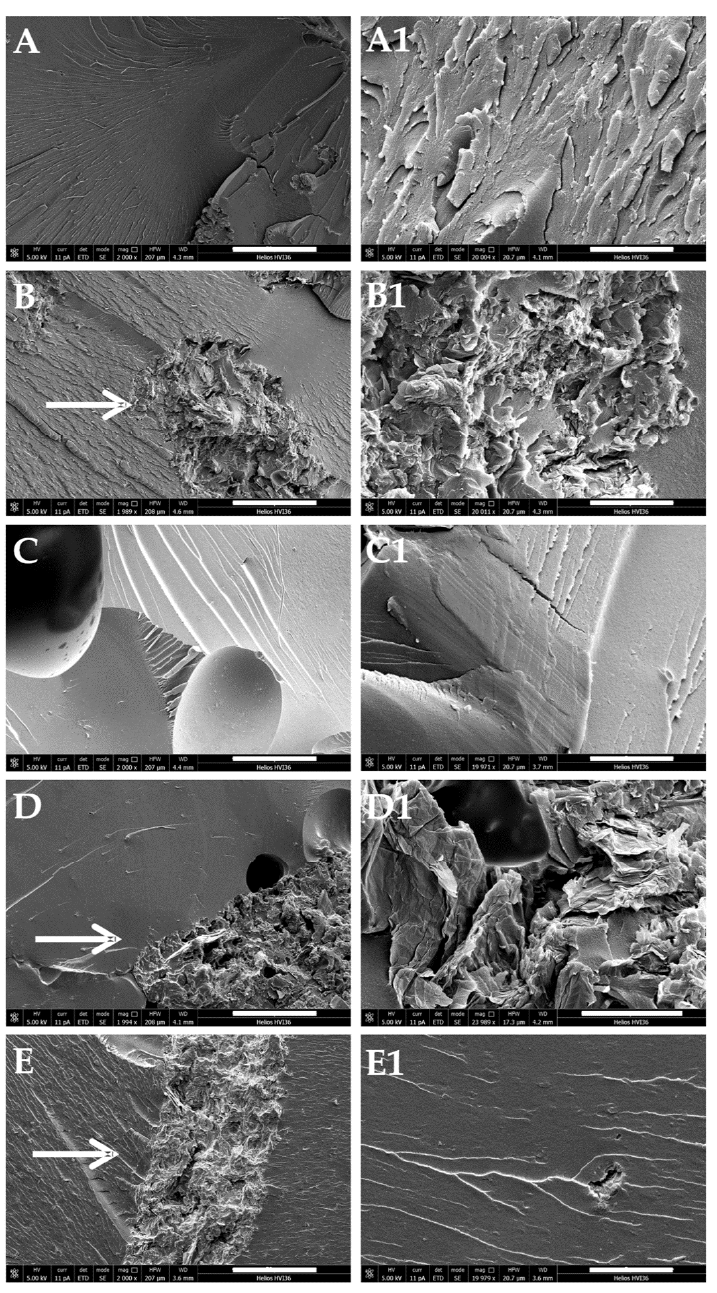
Figure 10. Scanning Electron Microscopy (SEM) micrographs at different magnification of the nanocomposite composed by PKFU/BISM and rGO at different weight percentage. ( A , A1 ) 1.6 wt%, right pictures scale bar 5 µ